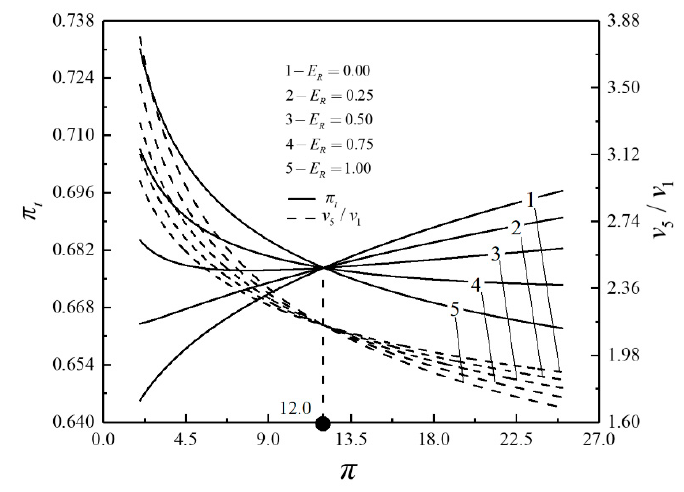
π π and 5 1 / v v versus with different R E .